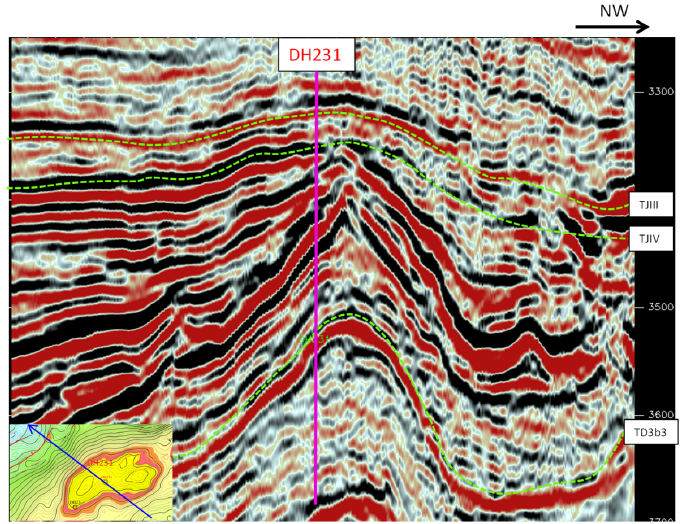
Figure 2. N–W seismic profile of Well DH231